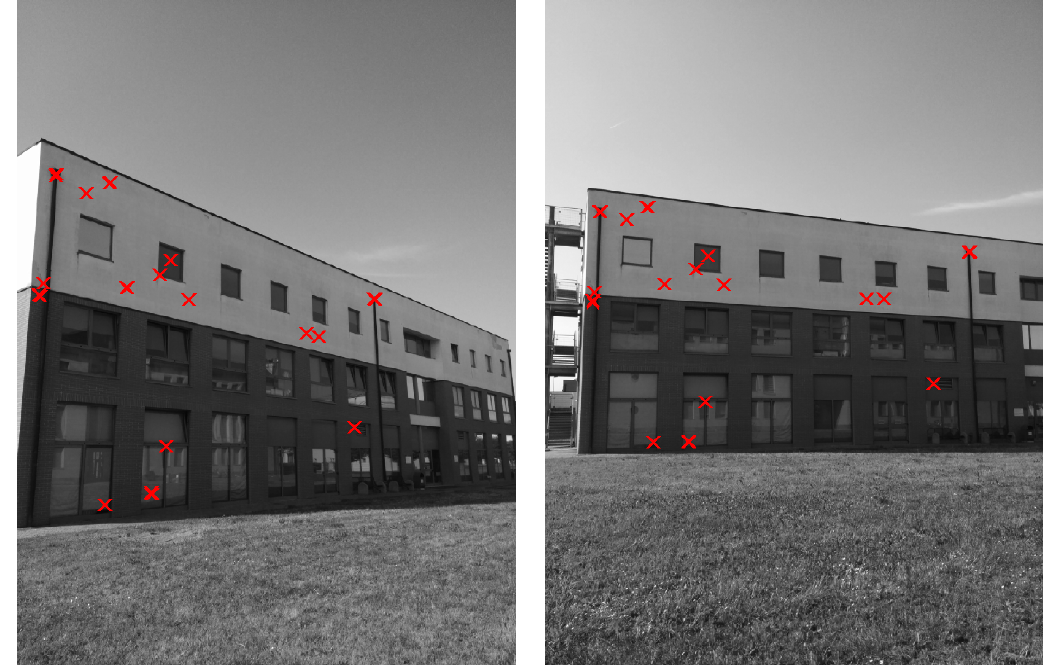
Figure 5. Example of feature points correctly matched by means of the technique proposed in Section 2 ( N =